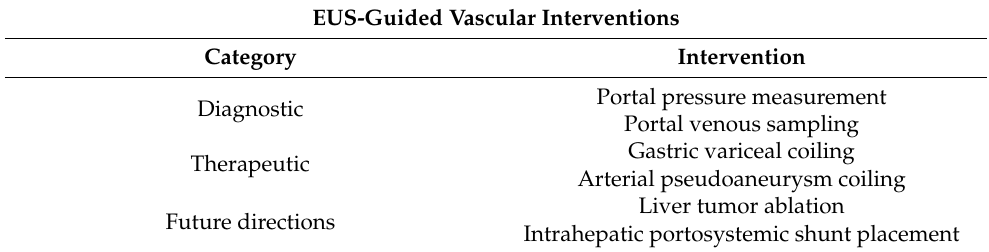
Table 1. General overview of current and future EUS-guided diagnostic and therapeutic